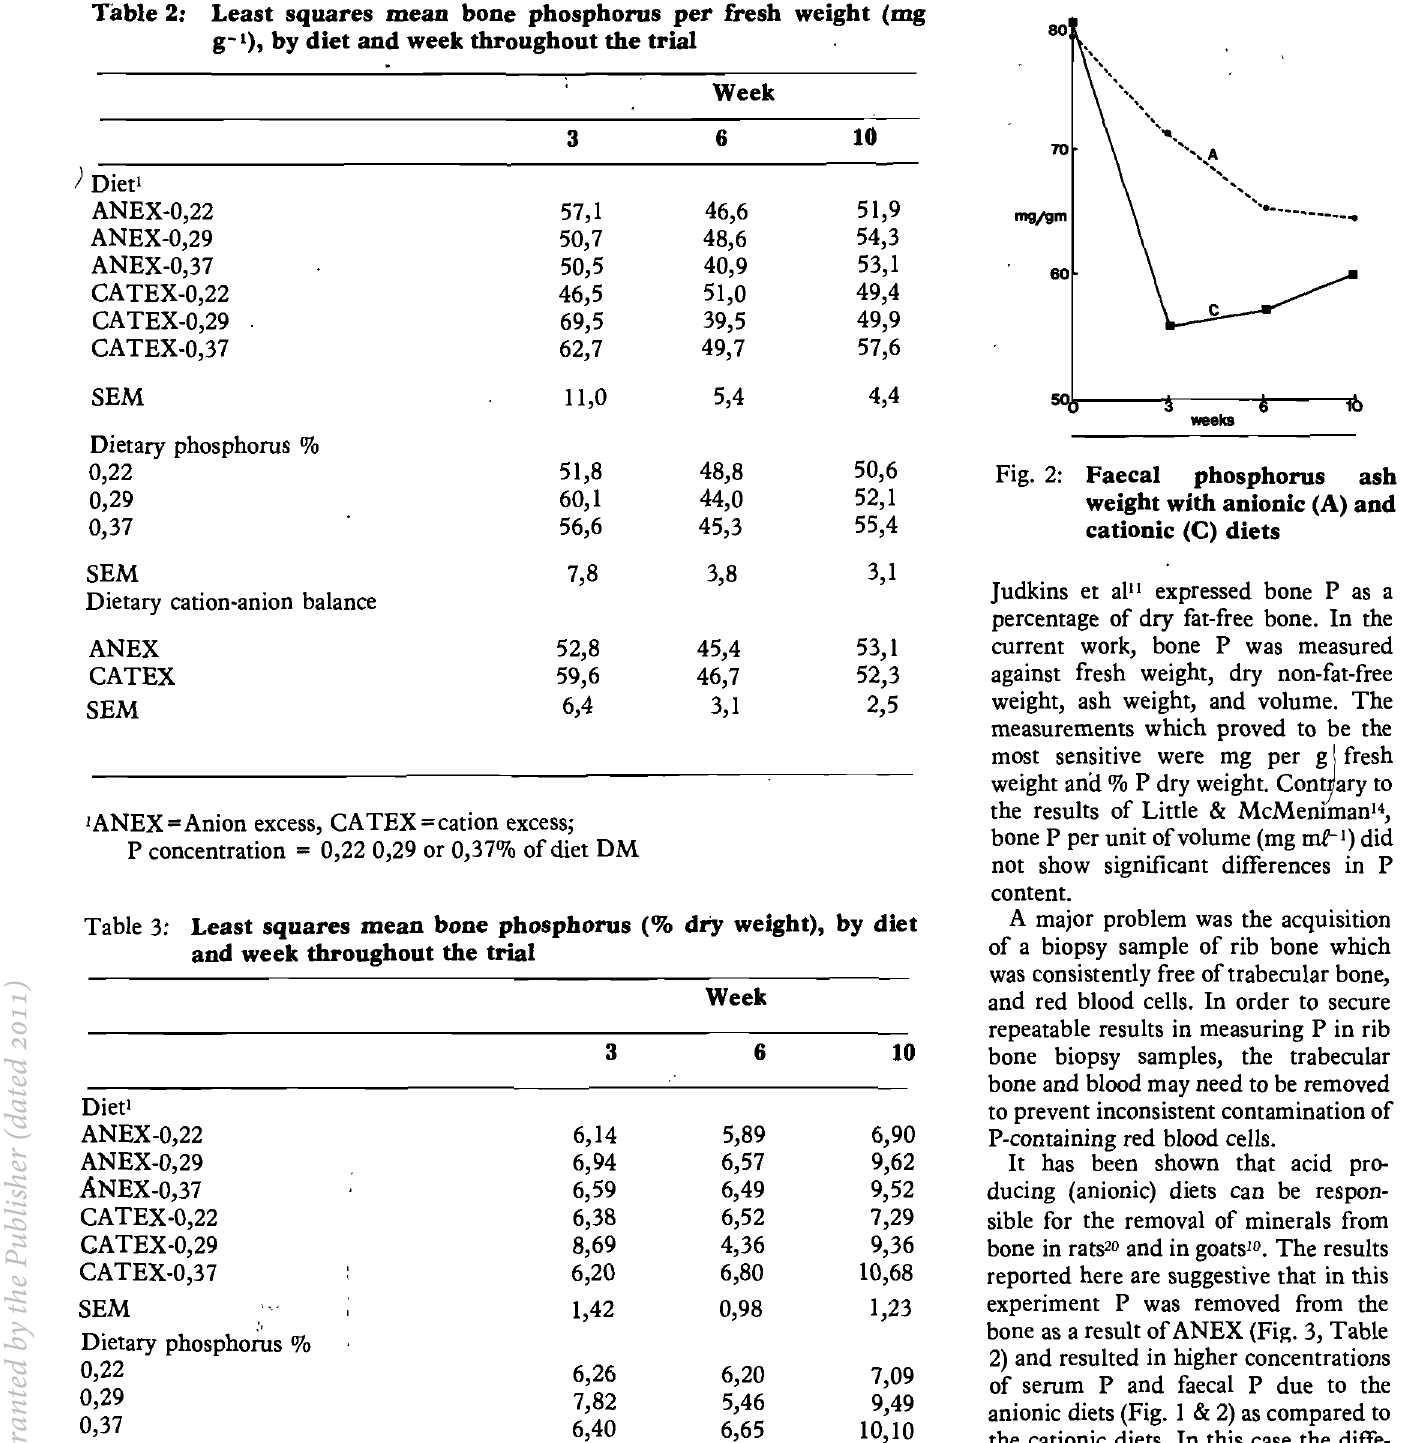
Table 2: Least squares mean bone phosphorus per fresh weight (mg g-I), by diet and week throughout the trial